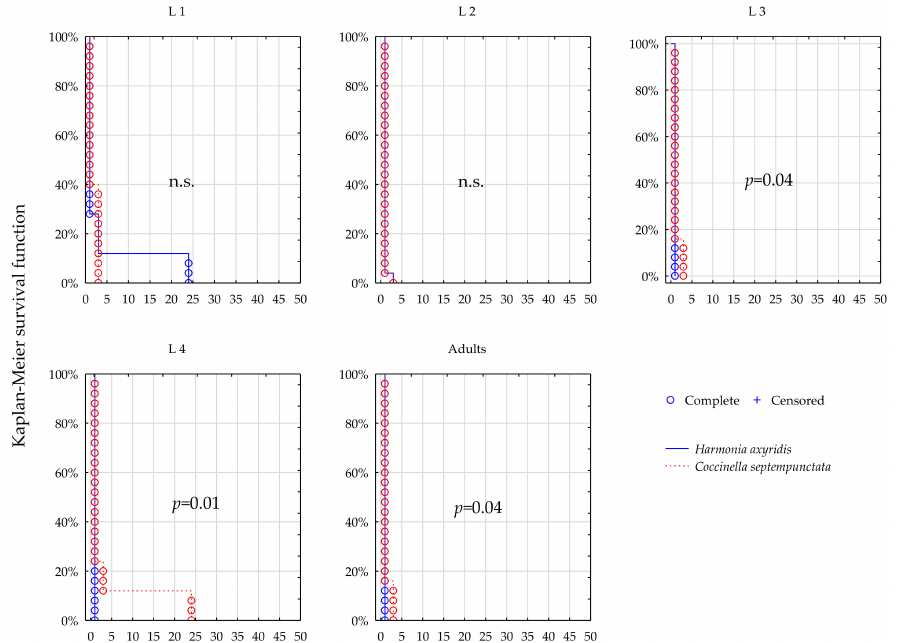
Figure 1. Survival dynamics of larvae and adults of the two predators after foraging on the prey treated with Karate Zeon at 100% recommended field rate.